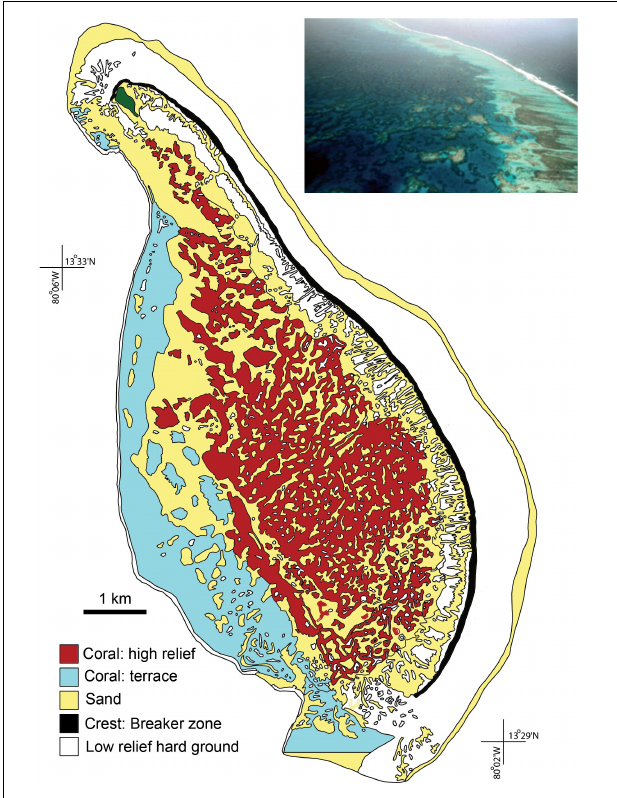
FIGURE 2 | Map of Roncador Bank environments emphasizing high relief sheltered coral communities (modified from: Diaz et al., 1996a; Sánchez et al., 2005). Inset photo showing a portion of the atoll (courtesy of J.